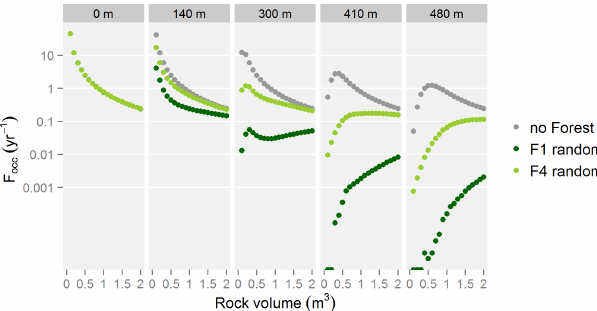
Figure 4. Occurrence frequencies of rockfalls (onset fre- quency × propagation probability) at different evaluation lines lo- cated at 0–480m downslope of the release area and for block vol- umes ranging from 0.05 to 2.0m 3 under forested (forest type 1 (F1): dark green; forest type 4 (F4): light green) and non-forested condi- tions (grey) with a random tree distribution, soil type 3 and rough slope conditions. Note that the y axis is log-transformed. 50 simu- lations were run per block.